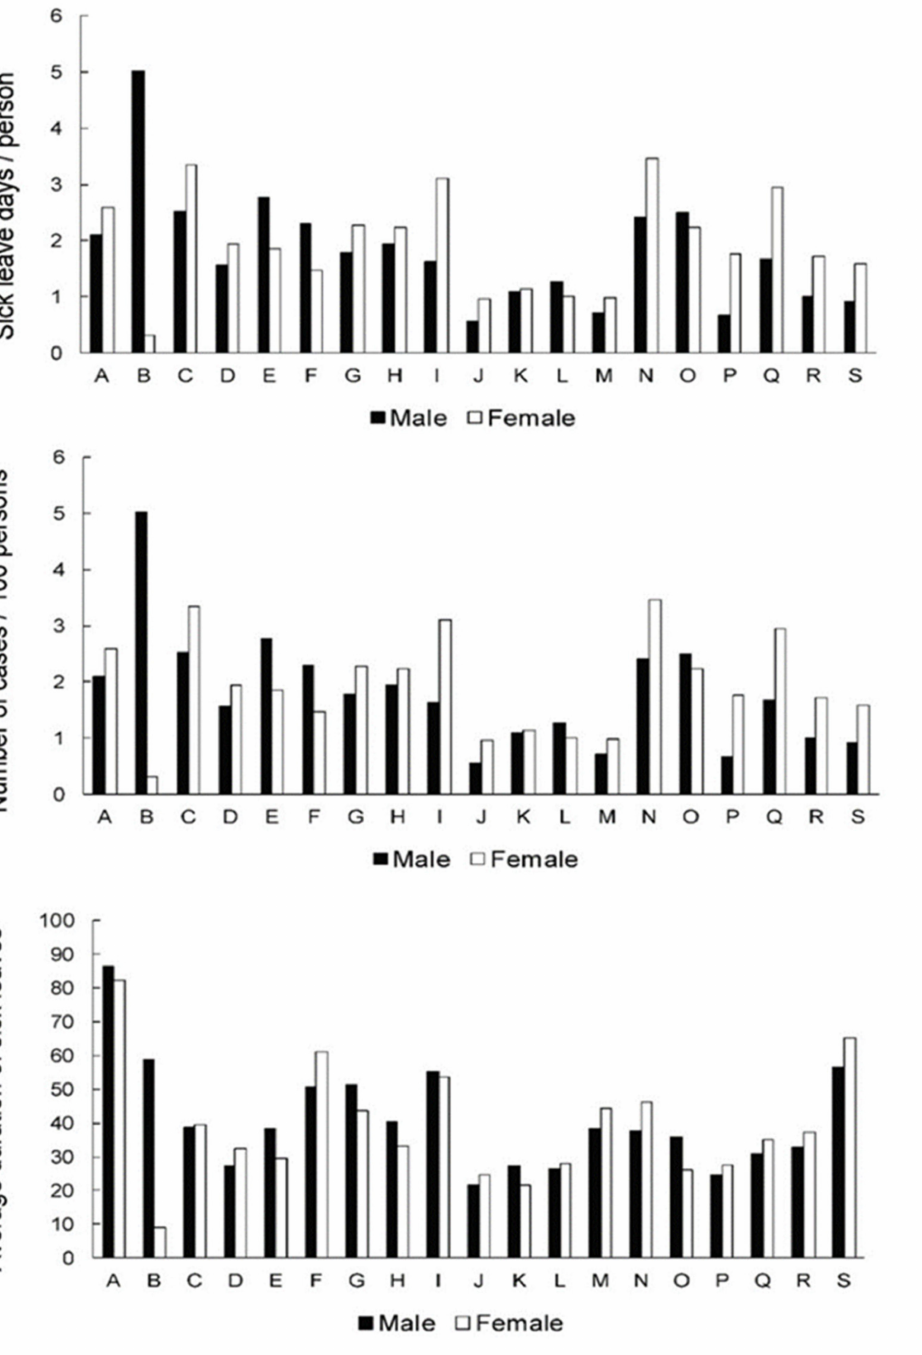
Figure 3. Sick leave days per person (index of temporary disability,) frequency of cases and severity (average case duration) of sick leave across genders and activities in 45.0–64.9-year-old group. A—agriculture, forestry and fishing; B—mining and quarrying; C—manufacturing; D —electricity, gas, steam, air cond. supply; E—water suppl; sewer., wst. manag., remed. act; F—construction; G—wholesale, retail; repair of mot. vehicles; H—transportation and storage; I—accommodation and food ser. activities; J—information and communication; K—financial and insurance activities; L—real estate activities; M—professional, scientific, technical act.; N—administrative and support service act; O—public admin, defense; compulsory soc. sec.; P—education; Q—human health and social work; activities; R—arts, entertainment and recreation; S—other service